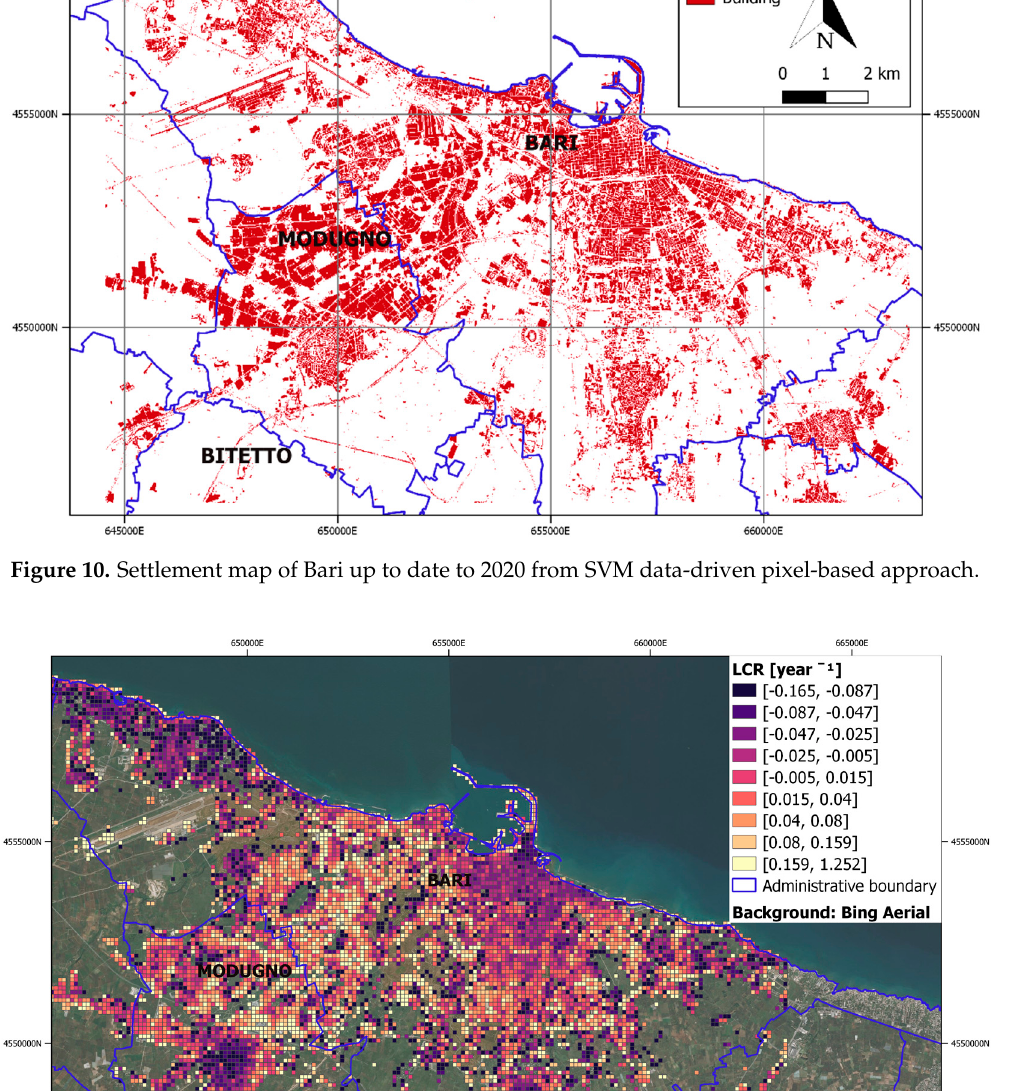
Figure 10. Settlement map of Bari up to date to 2020 from SVM data-driven pixel-based approach.